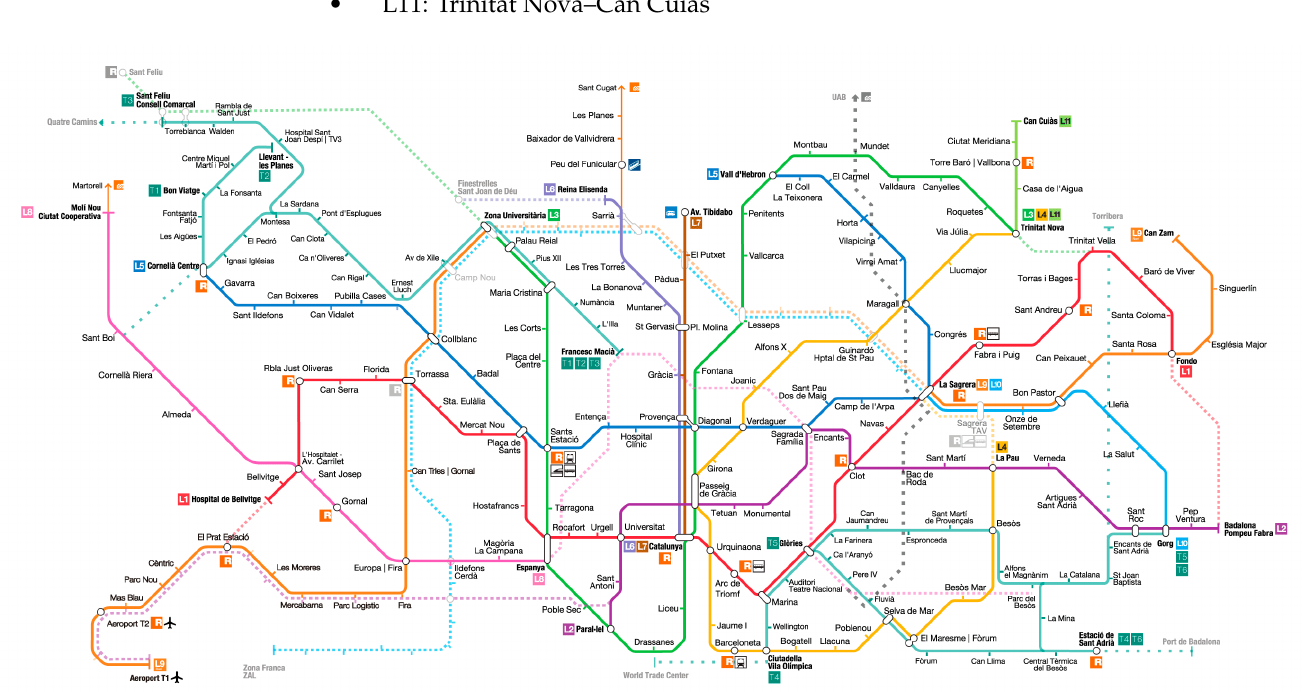
Figure 1. The 2019 Barcelona subway (Available online: https://www.metrobarcelona.es/mapas.html (accessed on 15 February